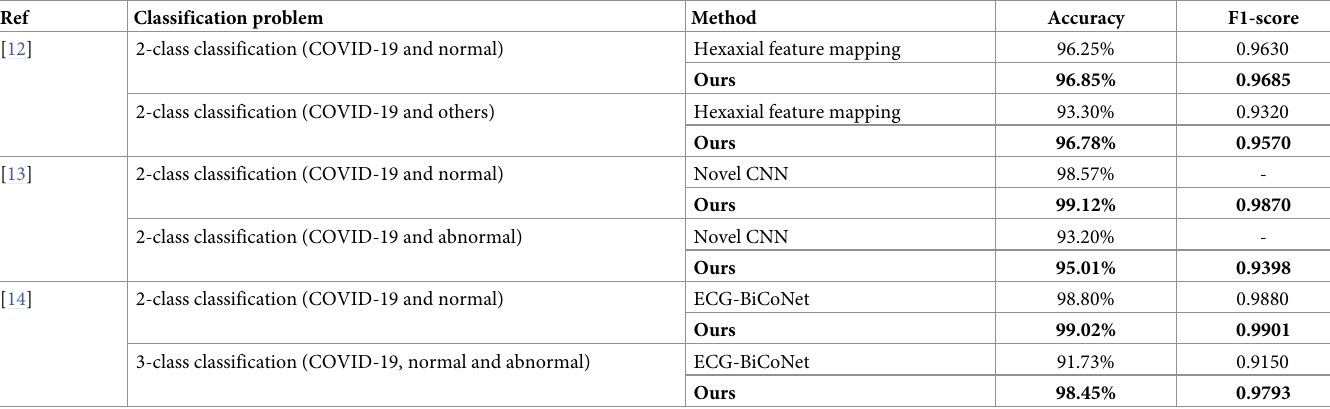
Table 4. Comparison to state-off-the-arts. To evaluate the efficacy of our method in comparison to others, data was split in a way that simulates related studies. Dashes (-) represent values not reported in the original paper. Our results are in bold. Ref Classification